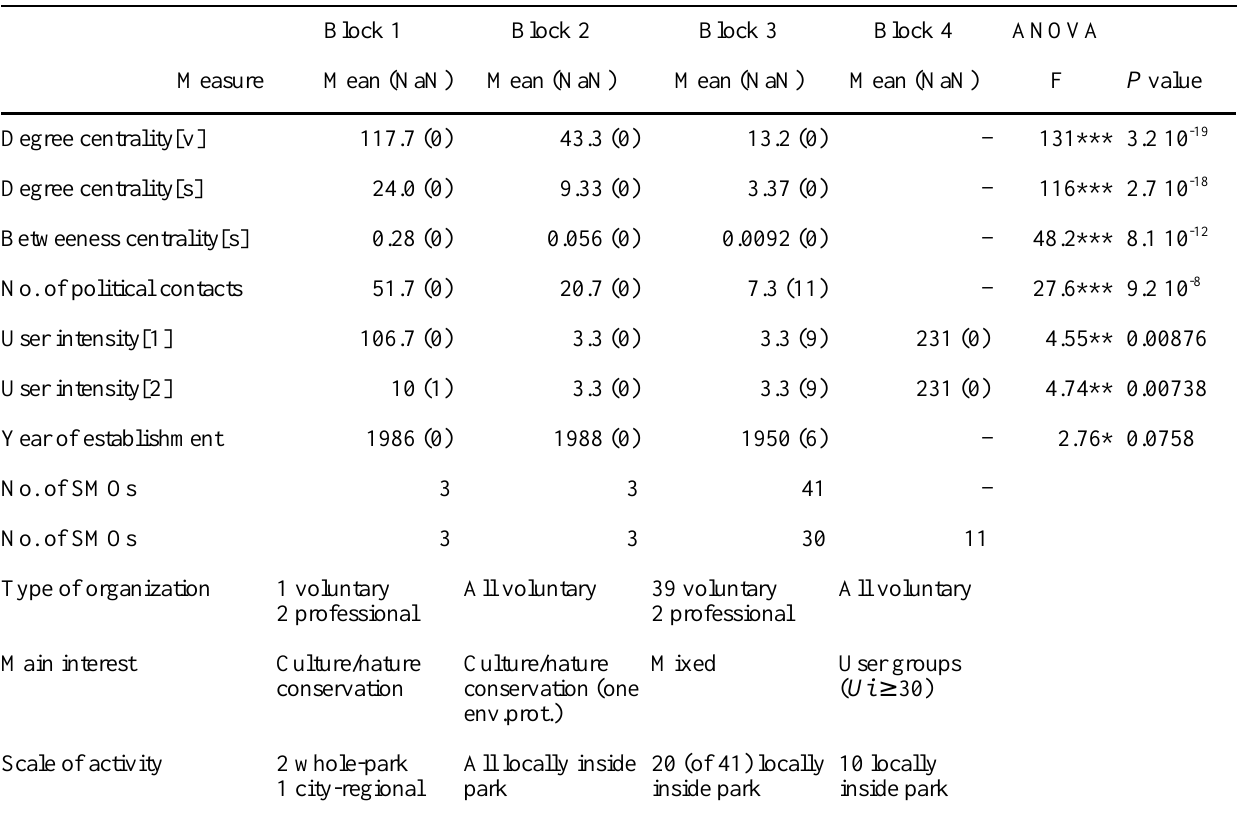
Table 2. The table describes the structural positions in the Main Component through the distribution of SMO attributes. The members of Block 4 are not strictly structurally equivalent, but a subset of heavy user groups from Block 3 (Ui ‡ 30). Note: [v] and [s] mean that the valued and symmetrical networks, respectively, were used for calculations; [1] and [2] mean that the user intensity was calculated with and without the outlier WWF, respectively. The number of missing data for each calculation is given within parenthesis